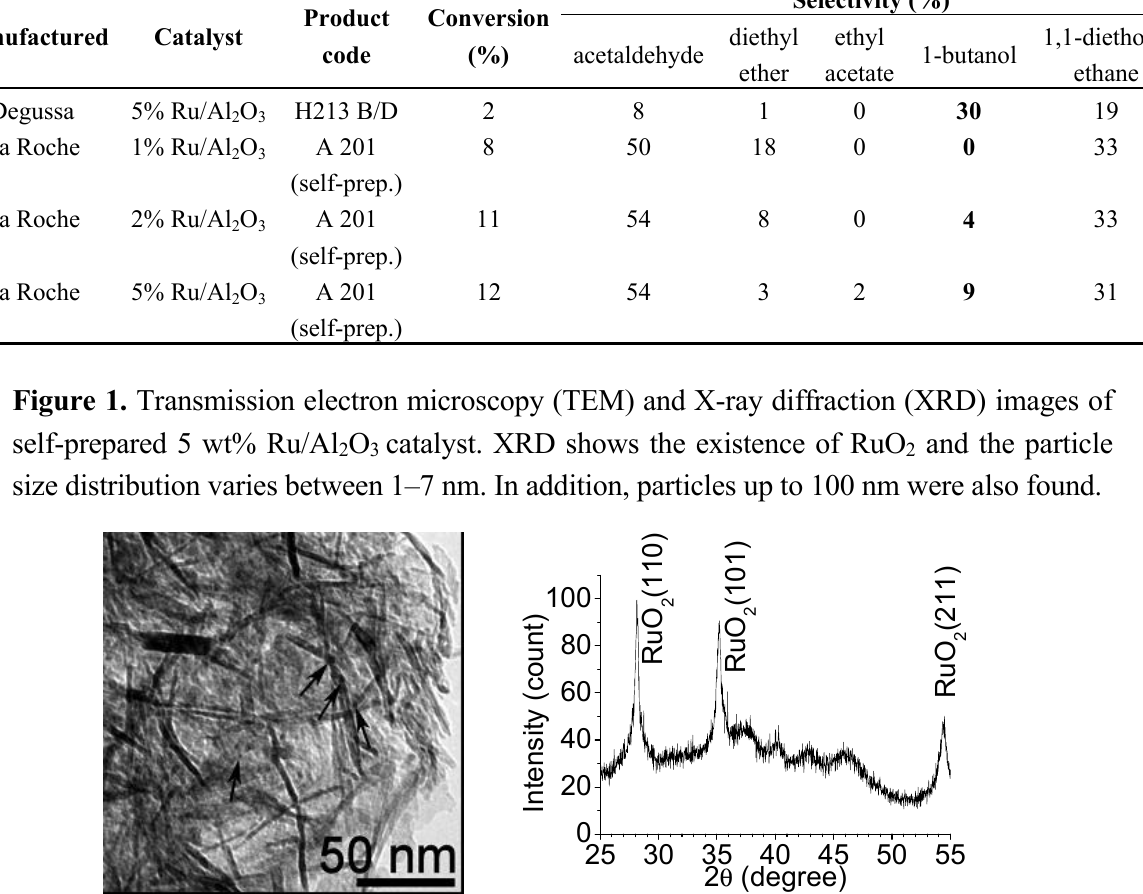
Table 3. Results obtained with alumina supported Ru catalysts.